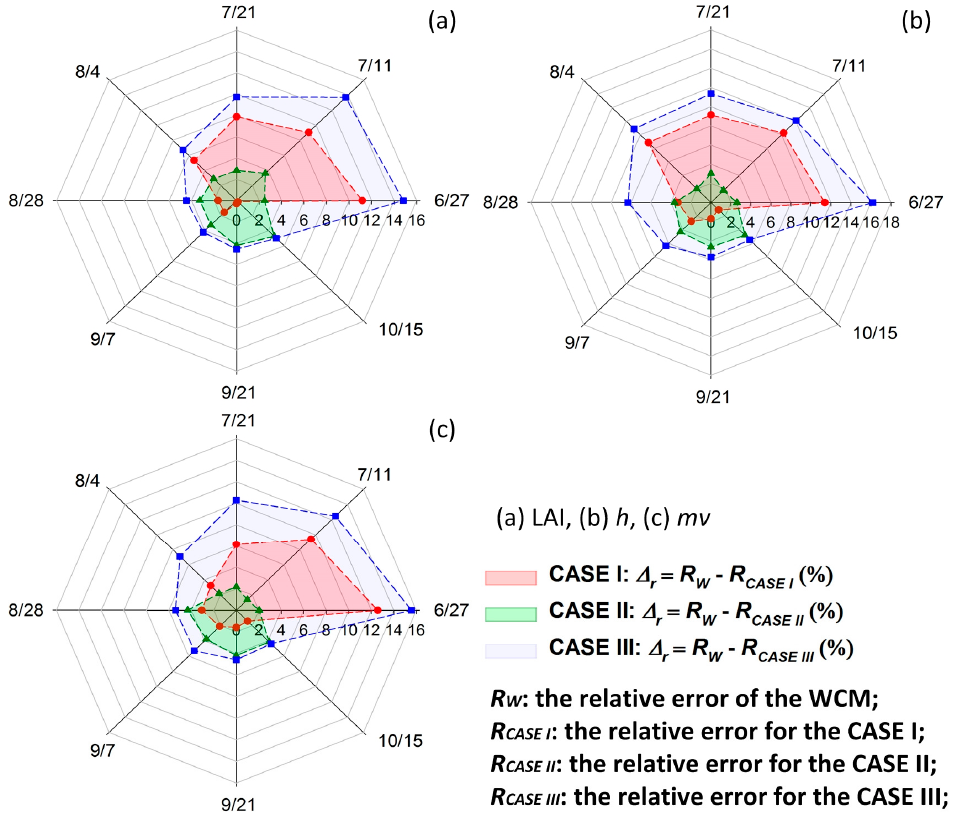
Figure 11. Comparison between the estimation accuracy in different cases. The ( a ) LAI, ( b ) h , and ( c ) m v is shown as an example.